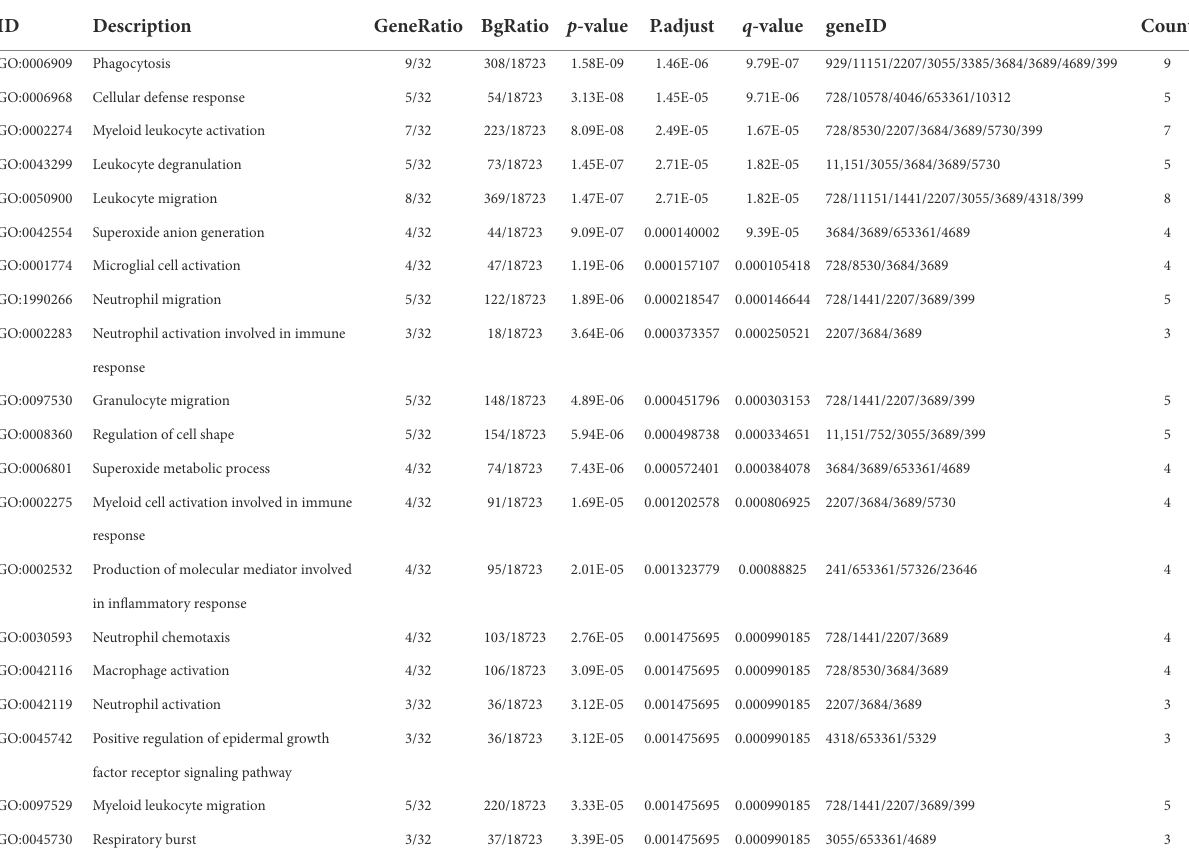
TABLE 3 The top 20 biological processes enriched by the crosstalk